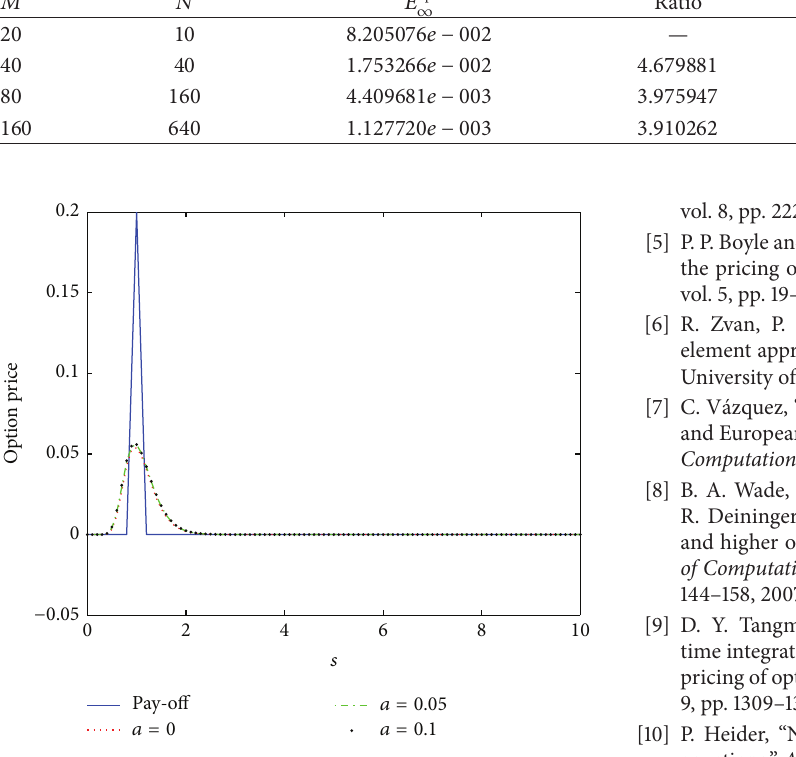
Figure 6: Option pricing of a European butterfly spread for several values of parameter 𝑎 at maturity time 𝑇 = 0.5 , where ℎ = 0.1 and Δ𝑡 = 0.05